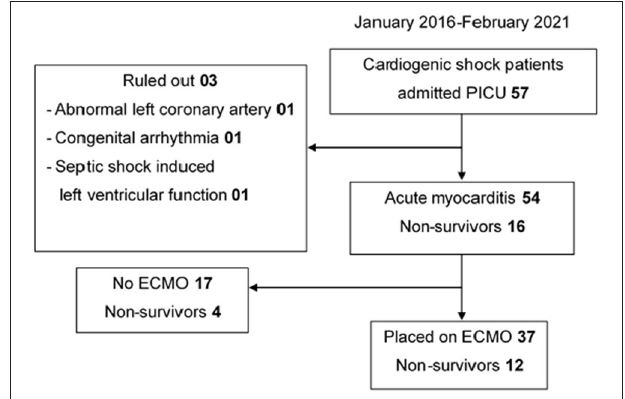
FIGURE 1 | Flowchart of enrolled cases. ECMO, extracorporeal membrane oxygenation.